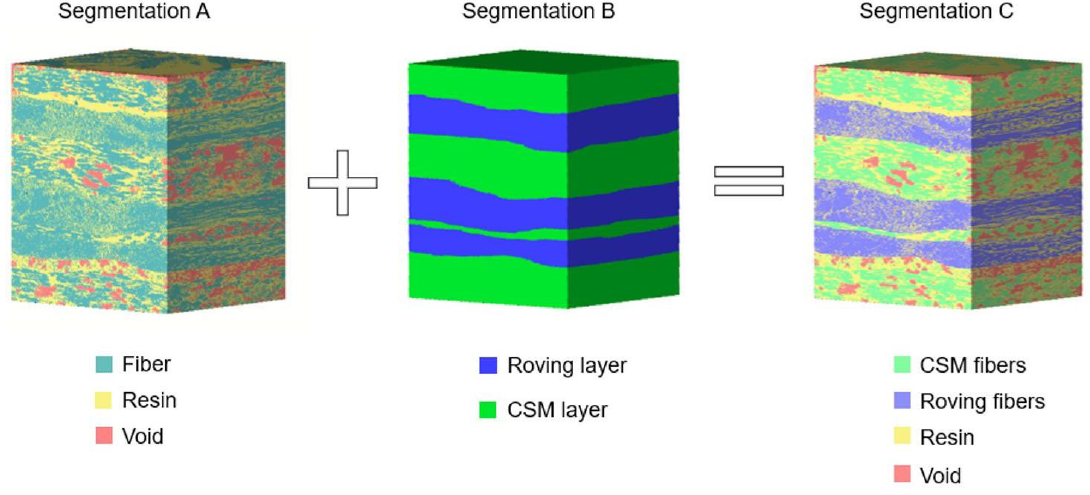
Figure 10. Combination of segmentations A and B to generate segmentation C.